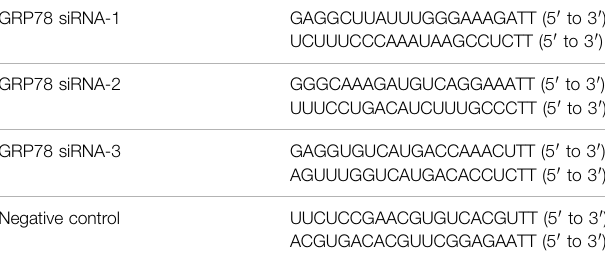
TABLE 1 | Antibody information. Antibody